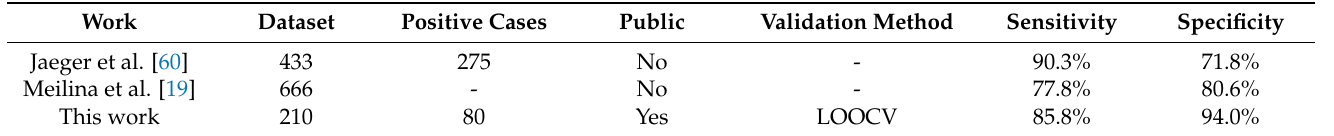
Table 3. Comparison of datasets used for mastitis detection using NIR